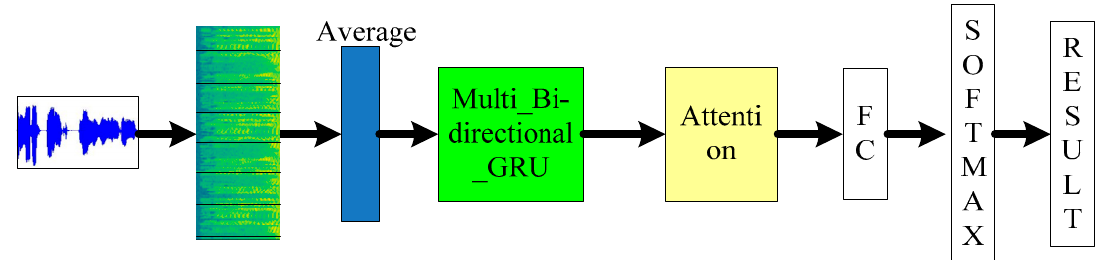
Figure 2. Gated recurrent unit (GRU) model combined with the attention mechanism.